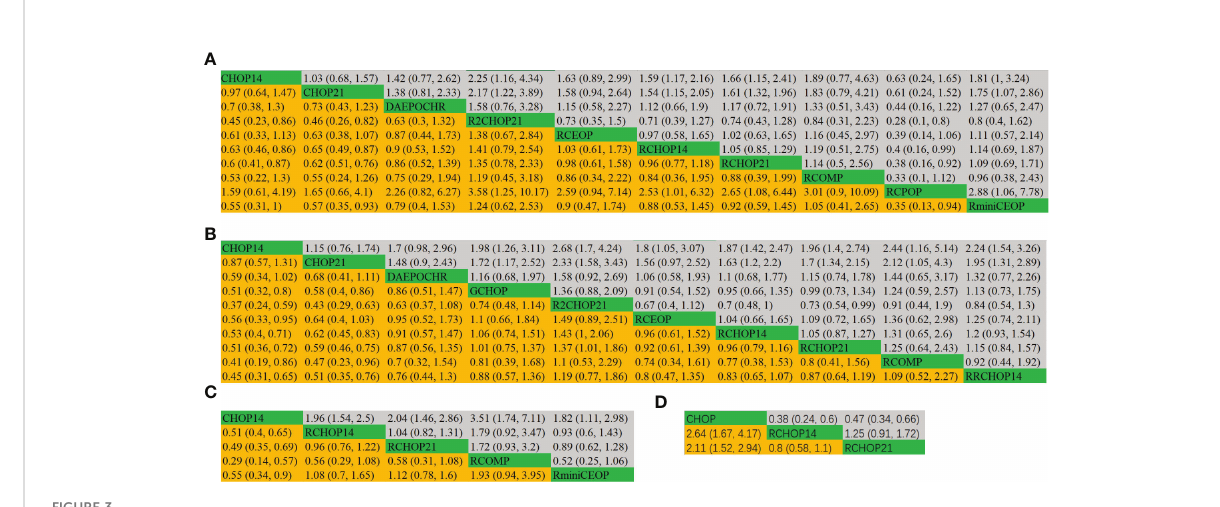
FIGURE 3 League table of (A) OS, (B) PFS, (C) EFS and (D)